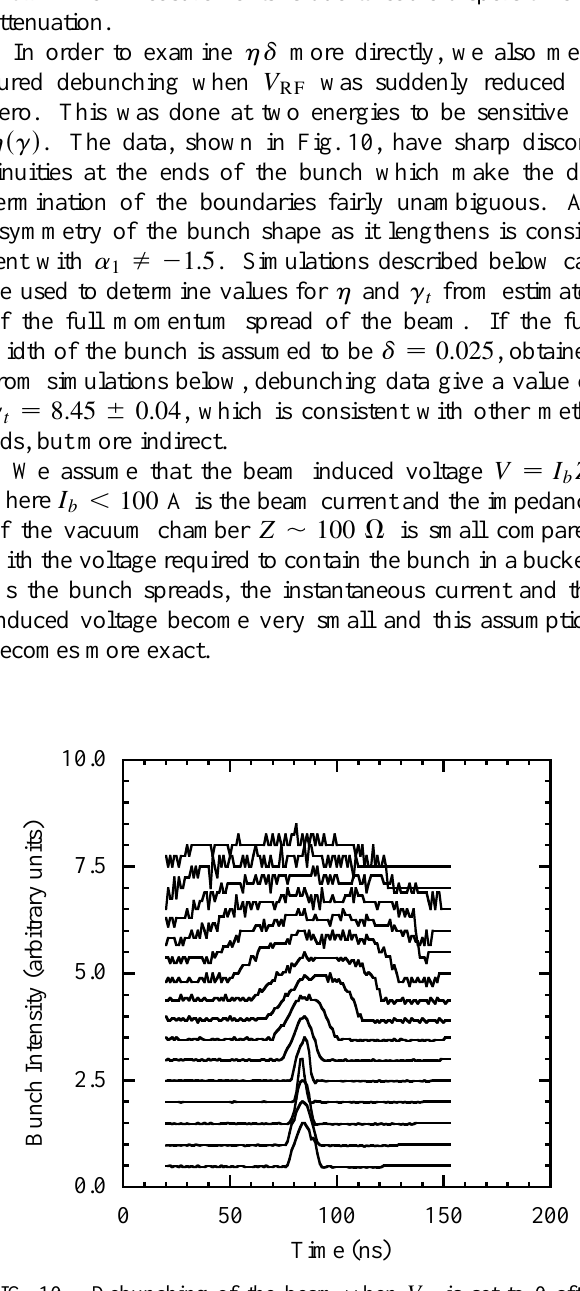
FIG. 9. Digital oscilloscope trace of final pulse shape using pulsed rf and the g (cid:116) jump, giving s (cid:44) (cid:50)(cid:46)(cid:50) ns (uncorrected) and 11.95 ns full width (between arrows).